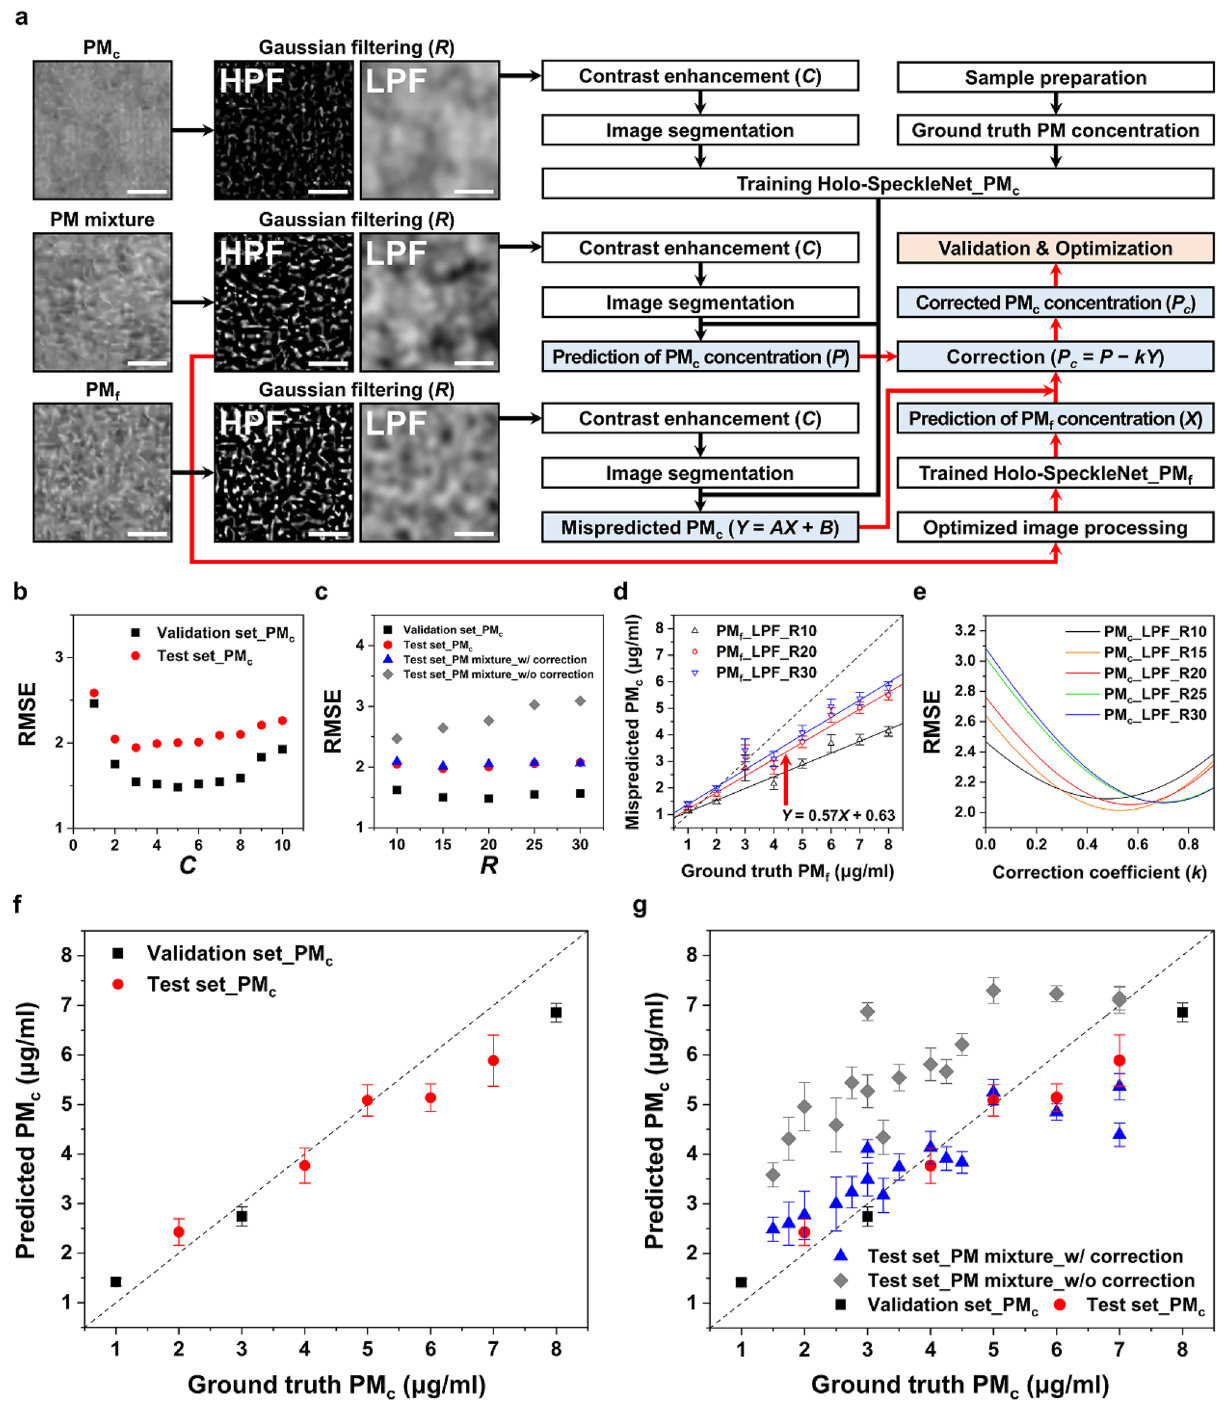
Figure 5. Smartphone-based measurement of PM c concentrations. ( a ) Overall workflow used to predict PM c concentrations. PM concentration labels of segment images: (PM f , PM c ) ρ f , ρ c = 8 µg/ml; (PM mixture) ρ f , ρ c = 6 µg/ml. Optimization of hyperparameters associated with digital image processing: RMSE variations according to ( b ) contrast enhancement parameter C and ( c ) Gaussian filter size R . ( d ) Mispredicted PM c concentrations of monodisperse PM f holograms filtered by LPFs with the Gaussian filter size R of 10, 20, and 30. ( e ) Optimization of correction coefficient ( k ) used in the correction procedure of mispredicted PM c concentrations. Predicted PM c concentrations of ( f ) monodisperse PM c and ( g ) polydisperse PM mixture samples. Scale bars are 10